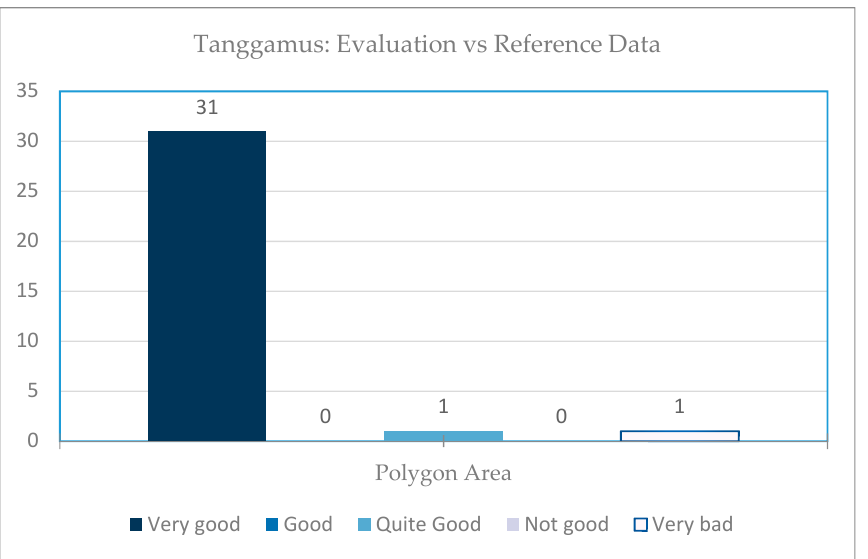
Figure 3. Analysis of the evaluation and reference dataset in Tanggamus .